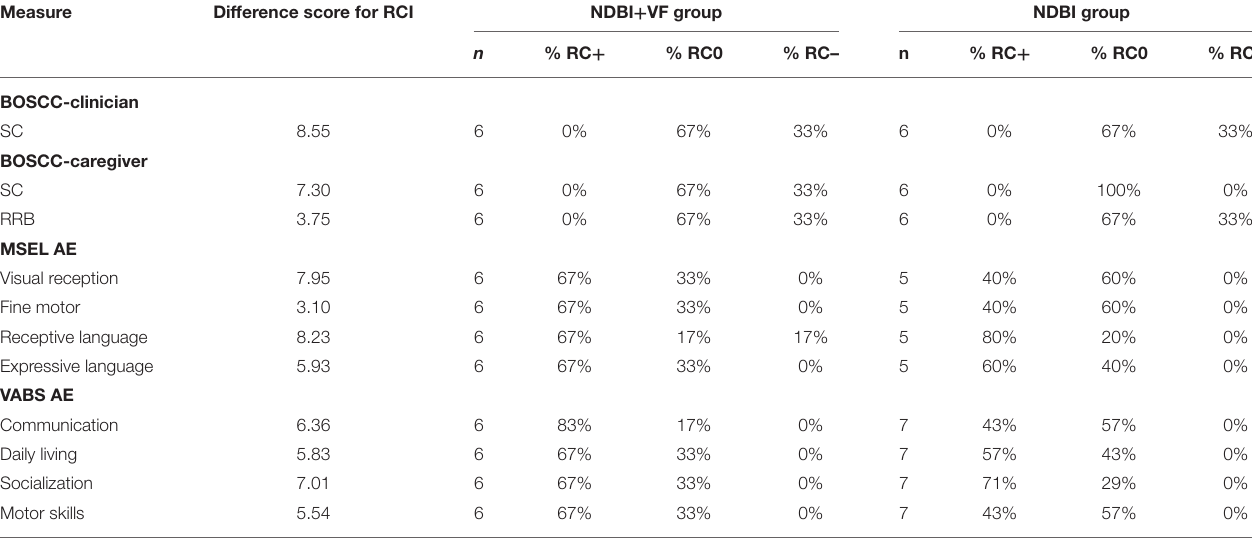
TABLE 3 | Reliable Change Indices from Intervention Entry to Exit. Measure Difference score for